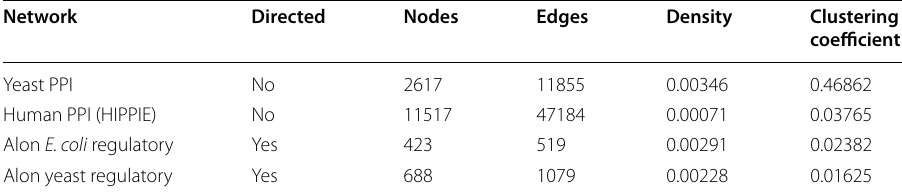
“Clustering coefficient” is the global clustering coefficient (transitivity)